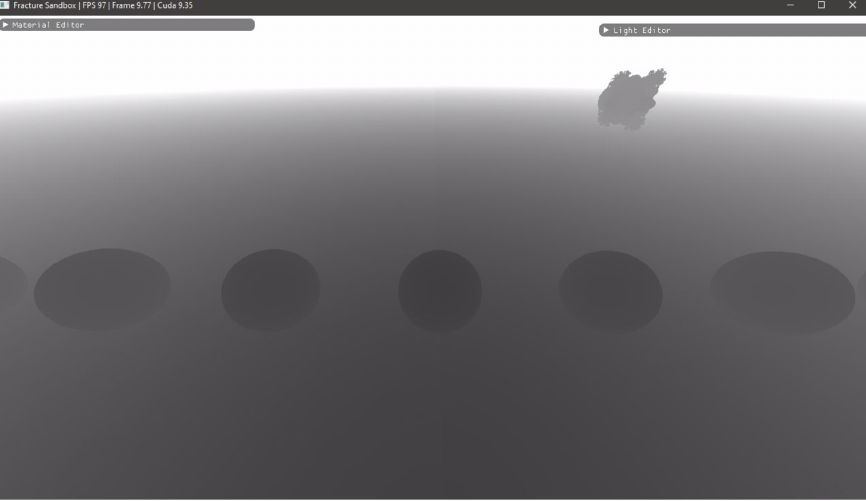
Figure 10. View 2: virtual depth buffer.